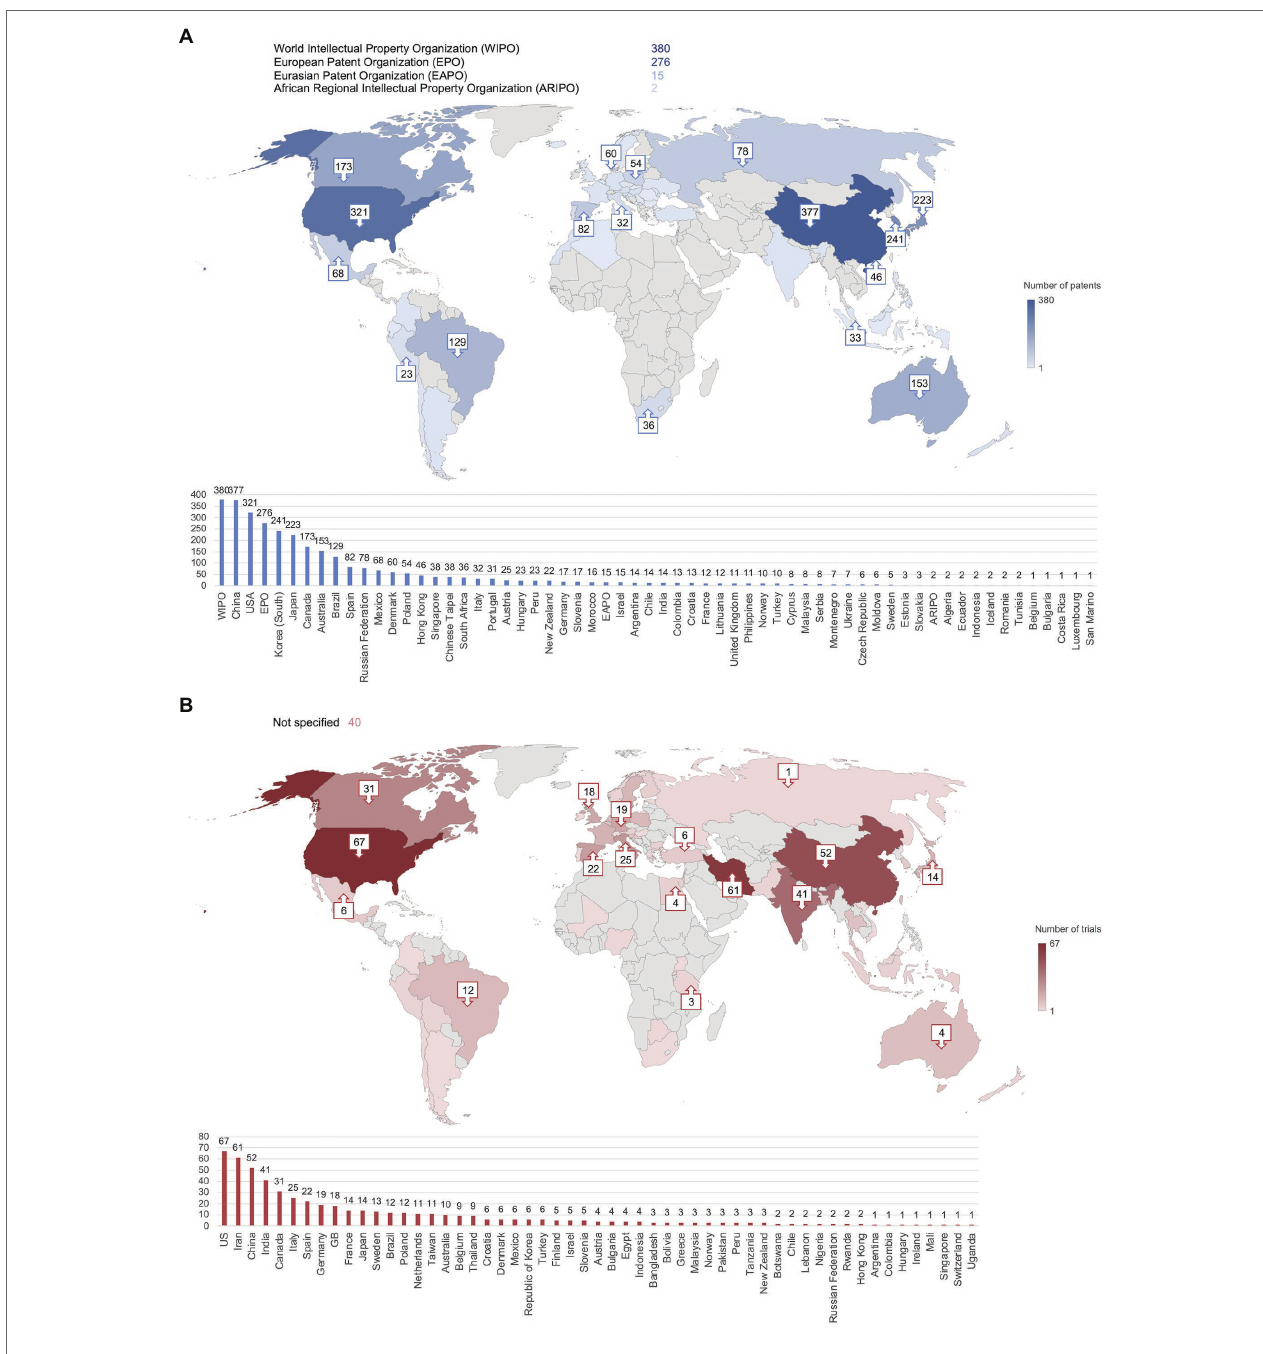
FIGURE 4 | China, the United States, South Korea, and Iran were the most frequently reported locations of patent applications and clinical trials. (A) Number of patent applications per country or organization. Total exceeds n = 789 due to most patents being applied for in multiple countries. (B) Number of clinical trials per country. Numbers not shown on the map are included in the bar